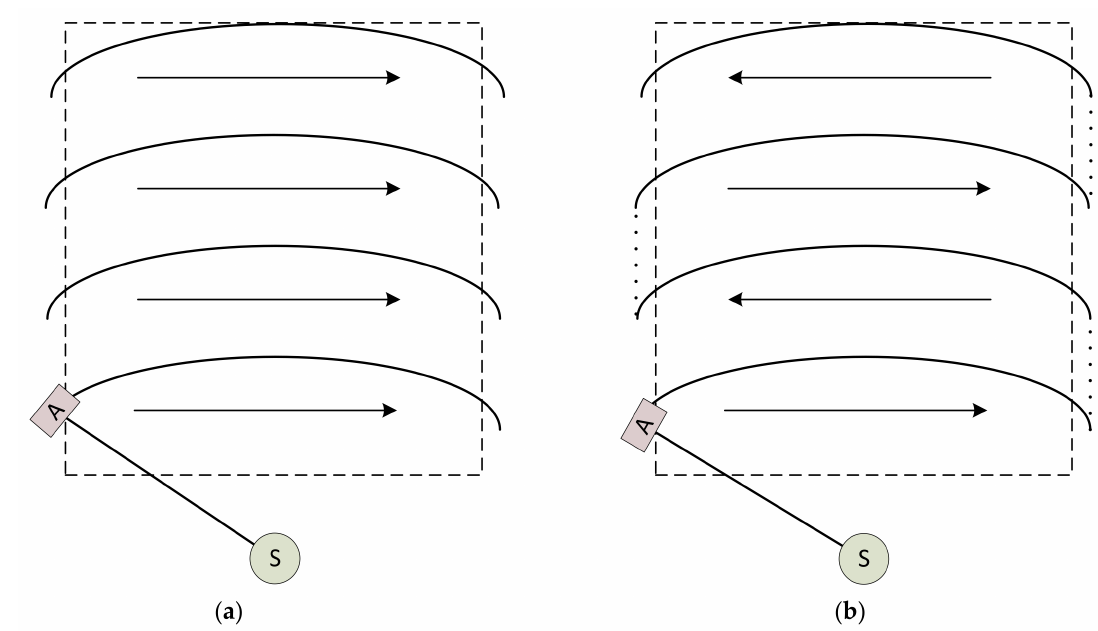
Figure 5. Scanning profiles typical for HH-GPR: ( a ) unidirectional; ( b ) bidirectional.